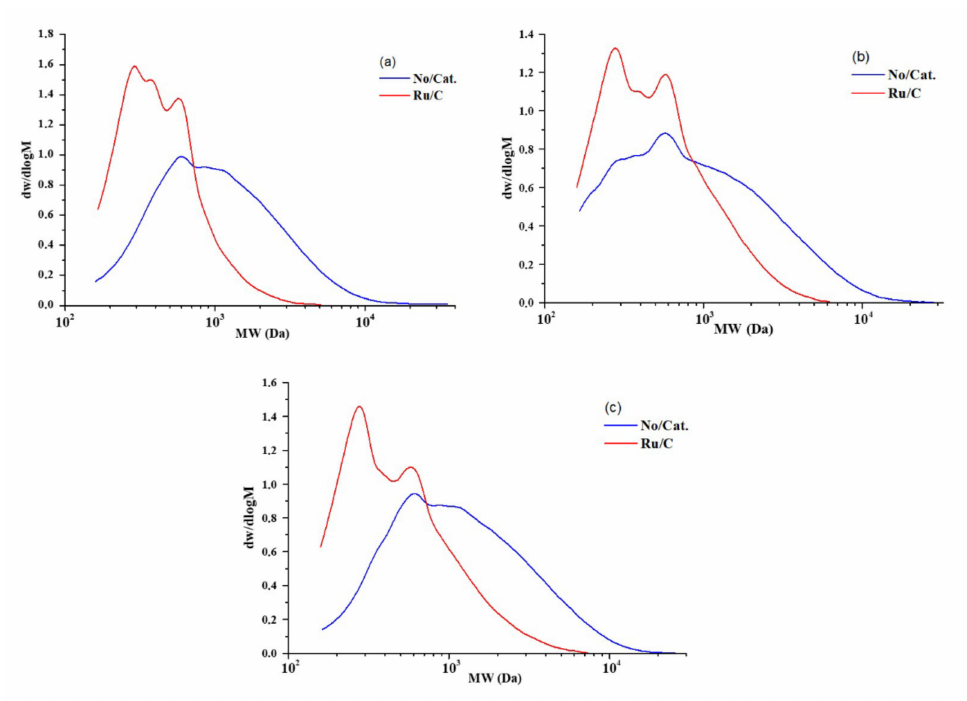
Figure 1. Molecular mass distributions of liquid products of hydrogenation of the initial ( a ), alkali-treated ( b ) and acid- treated ( c )